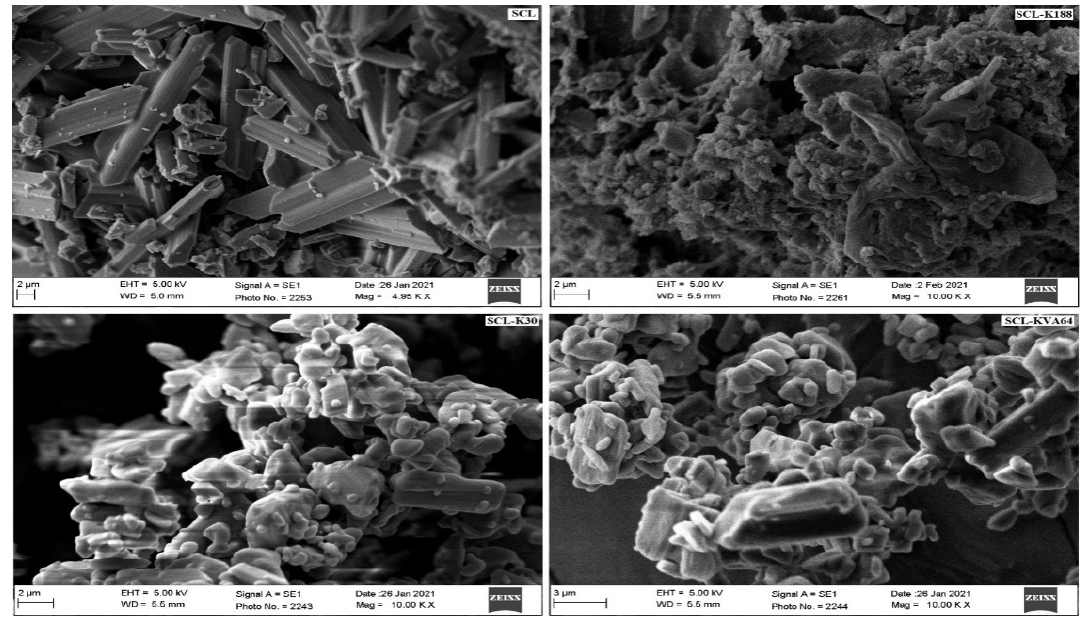
Figure 5. SEM images of pure SLC, SLC-K188, SLC-K30, and SLC-KVA64